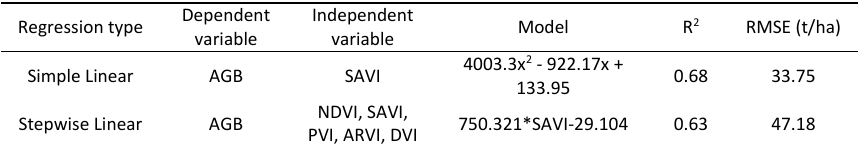
Table 5: Accuracy assessment of regression models Table 4. Accuracy assessment of regression models